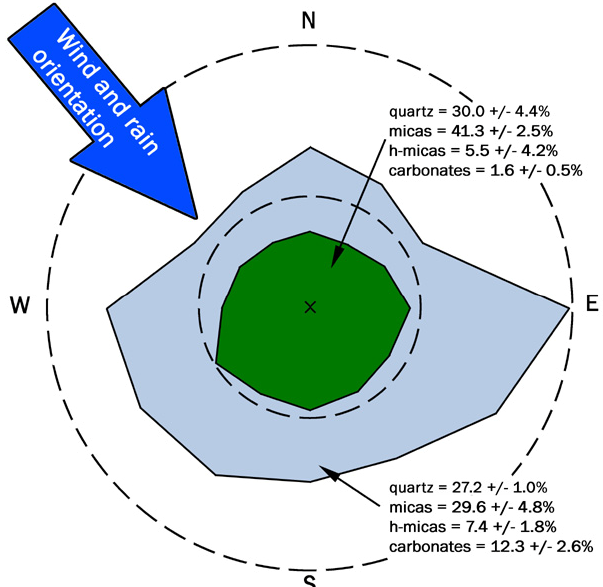
Figure 12. The dependence of weathering to the main wind and rain direction of slates “with carbonate” (turn blue) and “normal” slates (green): average values with inclusive standard deviation of some norm minerals. The distance from the center to the outside is the relative weathering intensity (altered based on [ 14 ] ).